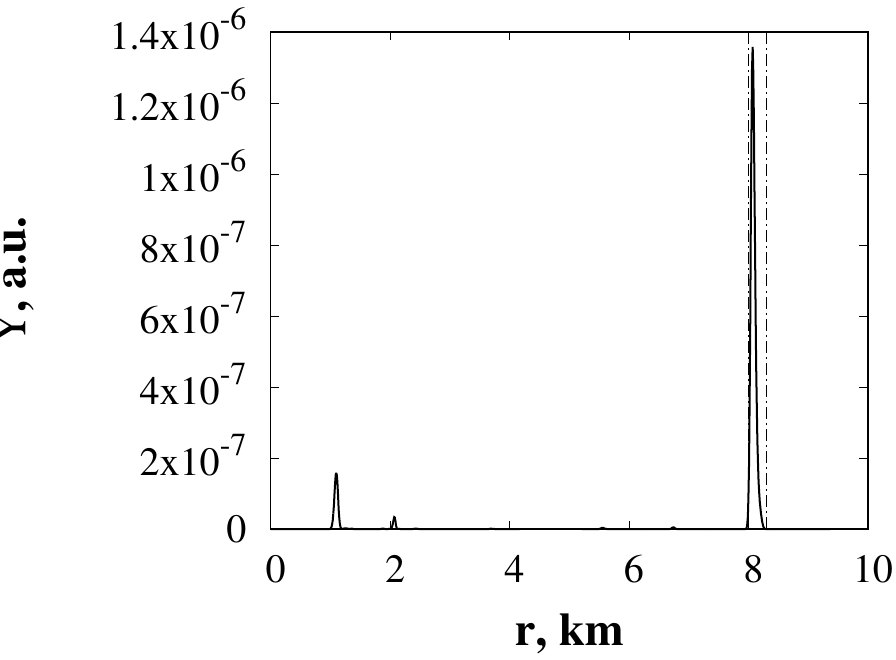
Figure 7. Solid line: overlap function Υ ( r ) for 16 beams corresponding to absorption spots for frequencies 100, 150, 200, 250, and 300 Hz. Vertical dot-dashed lines limit the pockmark